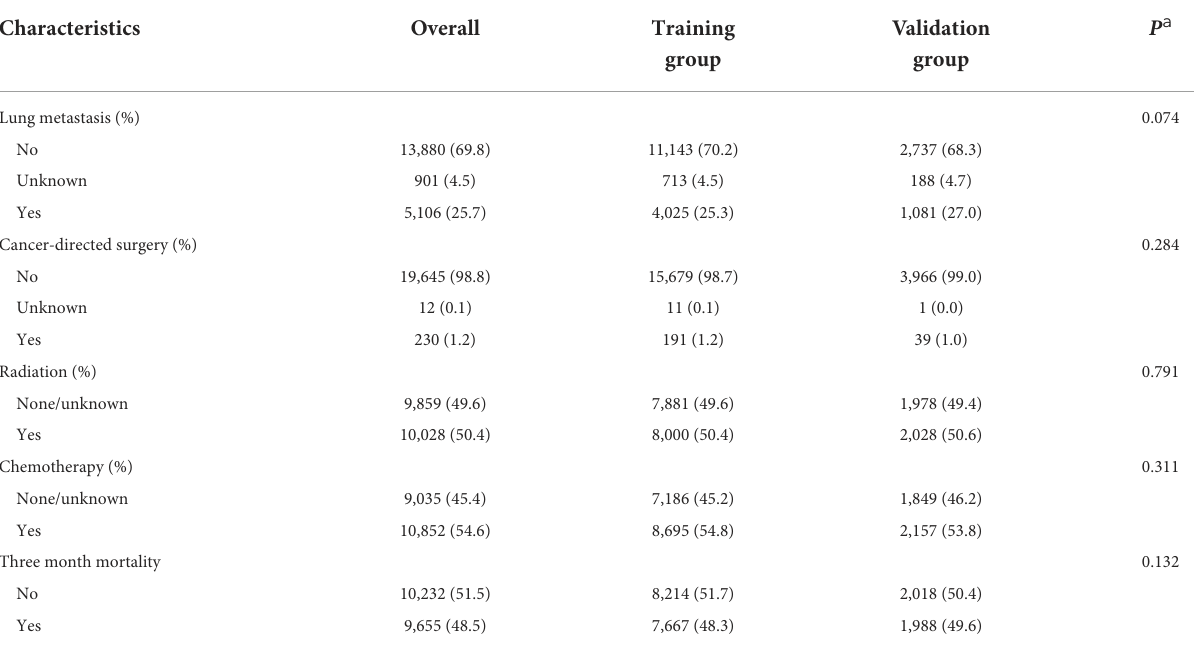
Table 3. Probability curves were plotted for each approach (Figure 3). With the least overlap in probability curves and the greatest separation of the two groups, these models—in particular the gradient boosting machine, XGBoosting machine, and logistic regression—demonstrated significant separation of the curves. To comprehensively evaluate the predictive performance and finally find out the optimal one, the optimal prediction effectiveness was assigned six points and the worst prediction effectiveness was assigned one point in each measure. The heatmap for prediction effectiveness among the six approaches is displayed in Figure 4. The gradient boosting machine approach performed best with the highest sum